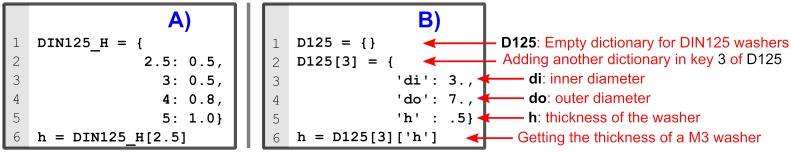
Sample codes of dictionaries for defining component dimensions in Python.(A) Dictionary DIN125_H defines the height (thickness) of some DIN 125 washers. Keys can be a float number, as in line 2. Line 6 shows how to obtain the height (0.5) of a DIN125 M2.5 washer from the dictionary. (B) Dictionaries can be multidimensional and can have strings as keys.